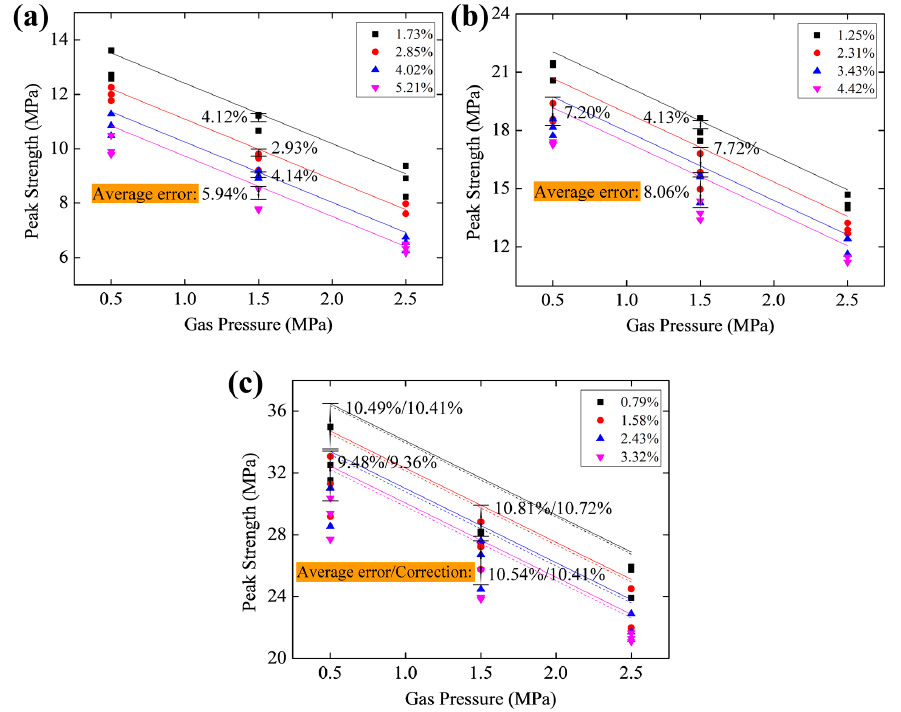
Figure 11. Relationship between peak strength and gas pressure: ( a ) Songzao; ( b ) Pingdingshan; and ( c ) Tashan.